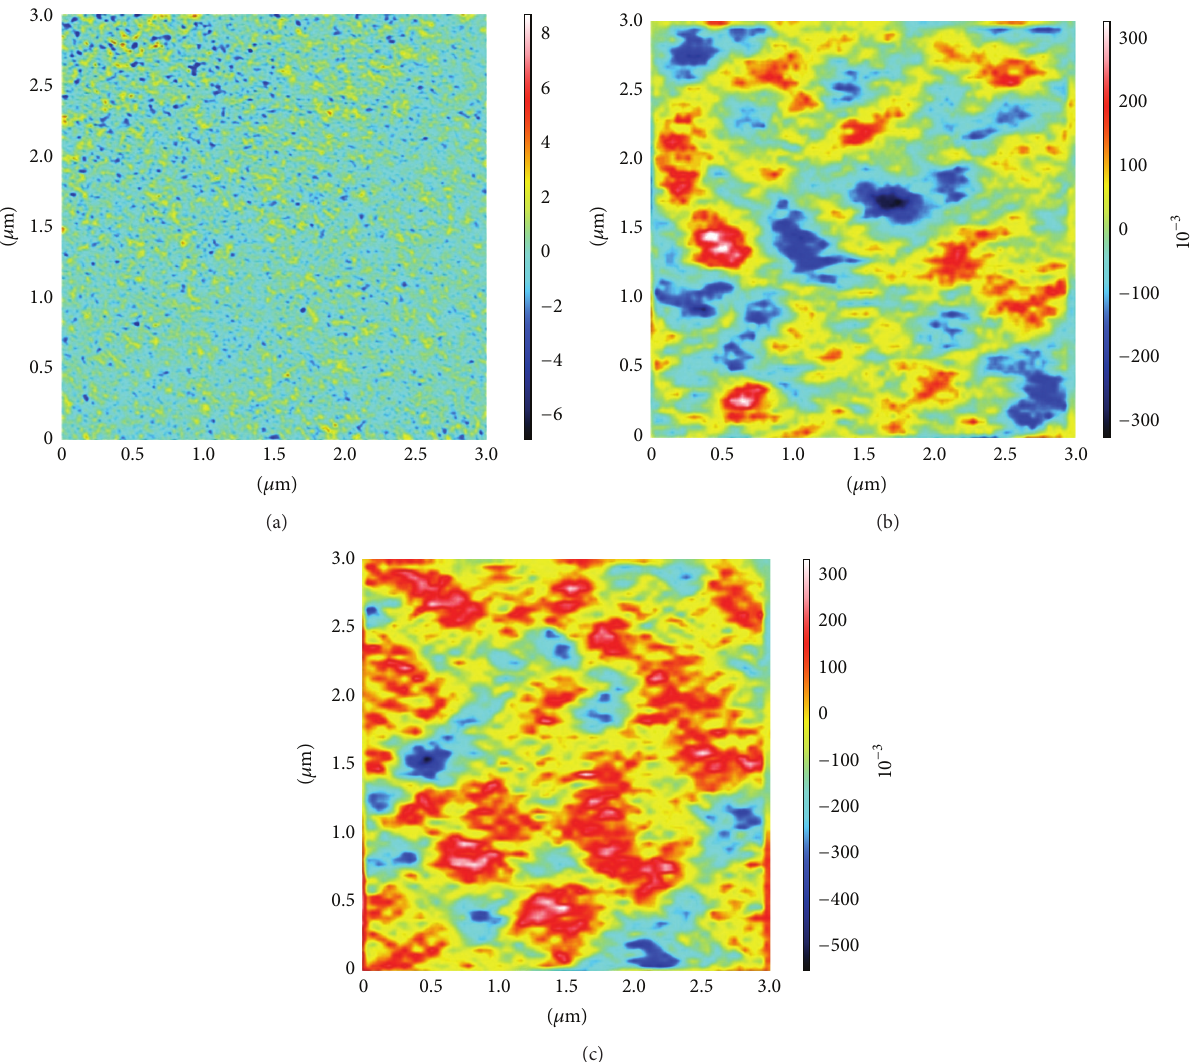
Figure 5: AFM phase images of P3HT:PCBM films (a) without annealing treatment, (b) with thermal annealing for 10 min, and (c) with laser/thermal coannealing for 5